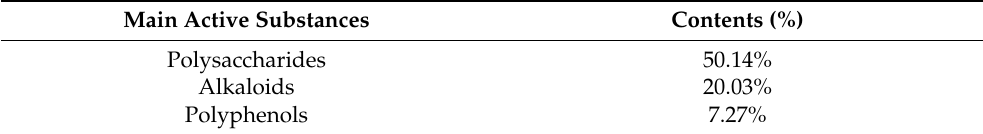
Table 3. Main active substances in SBE.